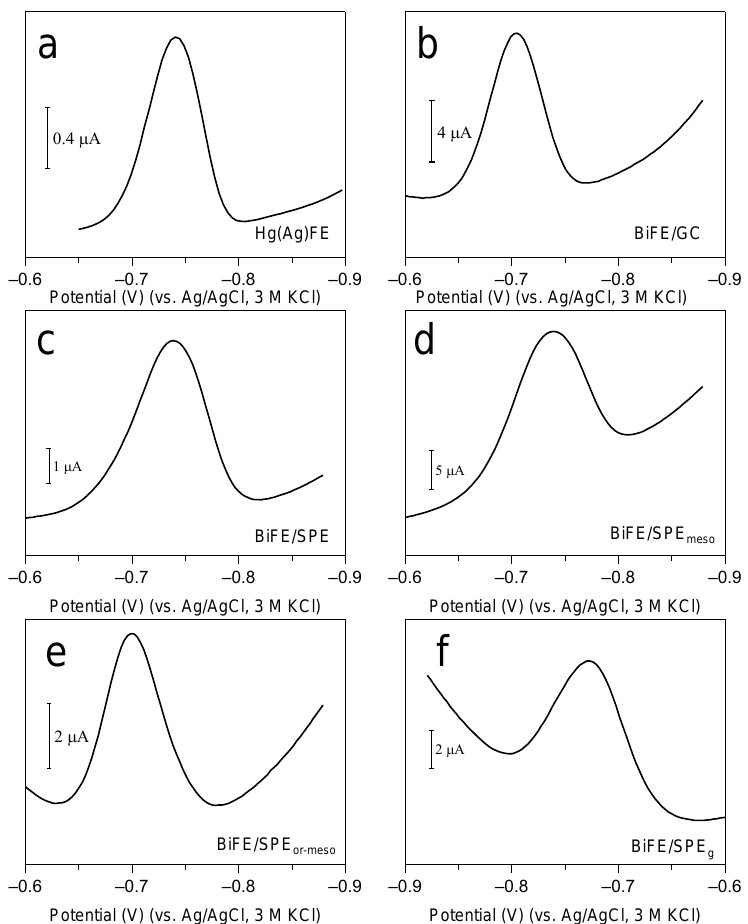
Figure 9. DP AdSV voltammograms recorded for solutions containing for 10 nM of Ge(IV) ( a ) (Hg(Ag)FE only) and ( b – f ) 30 nM of Ge(IV)—using bismuth films plated on ( b ) GC (BiFE/GC), ( c ) carbon SPE (BiFE/SPE), ( d ) mesoporous carbon SPE (BiFE/SPE meso ), ( e ) ordered mesoporous carbon SPE (BiFE/SPE or-meso ), ( f ) and graphene SPE (BiFE/SPE g ). Composition of the supporting electrolyte: 0.05 M of acetate buffer, 1 mM of catechol, 1 mM of V(IV) and 1.5 mM of HEDTA. In- strumental parameters: E acc = − 0.2 V (Hg(Ag)FE) or E acc = − 0.4 V (BiFEs), t acc = 80 s (Hg(Ag)FE) or t acc = 30 s (BiFEs). Bismuth film electrode preparation: electrodeposition at − 0.9 V in a 0.04 M Bi(III) solution, carried out for a period sufficient to transfer a charge of 7.07 mC per mm 2 of the surface area of the support electrode